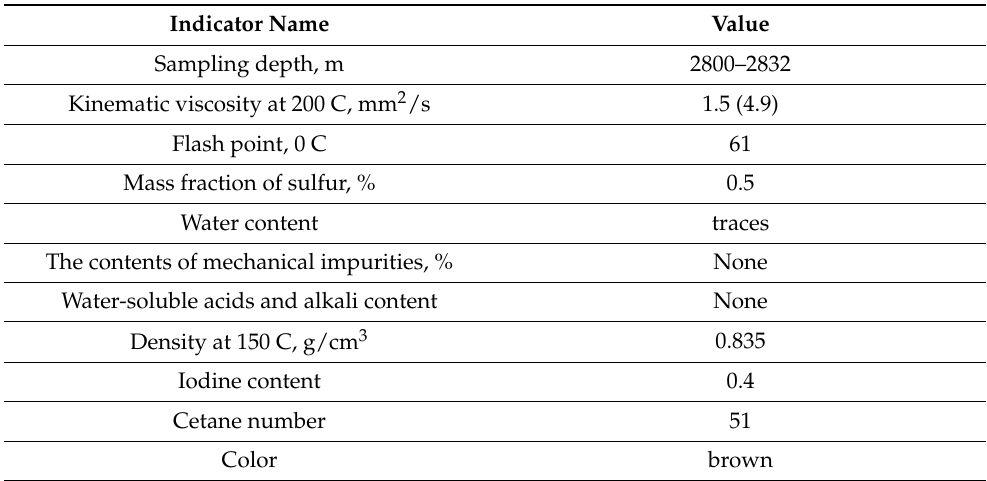
Table 2. Physico-chemical characteristics of the oil in this study.